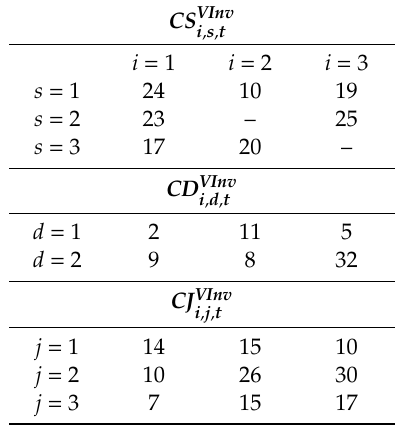
Table A23. Unit variable inventory cost ( € ) (considered here the same for any time period).